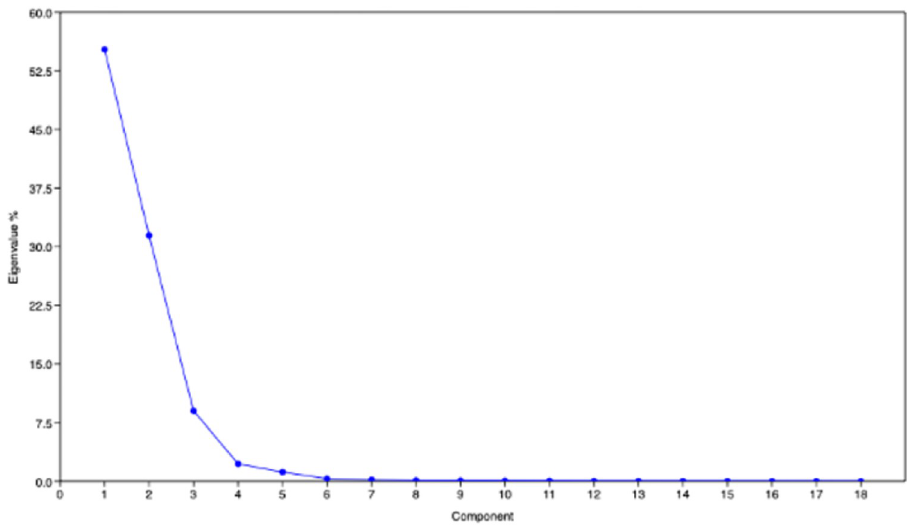
Fig 8. Scree plot of different principal components in PCA using quantitative and qualitative